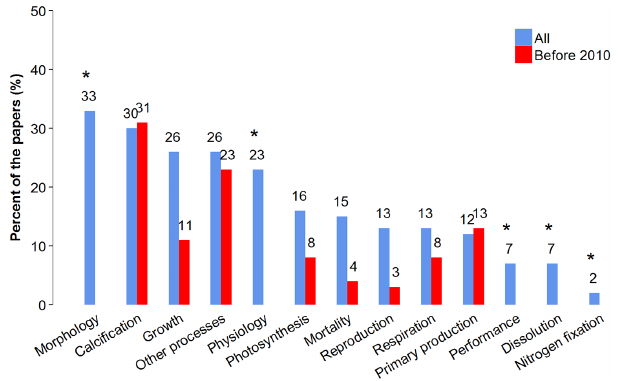
Figure 4. Biological processes reported in the papers from which data have been included in the OA-ICC data compilation, com- pared to those archived prior to 2010. Other processes studied in the papers from which data were archived before 2010 comprise variables such as shell length, width and linear extension of mol- luscs, bleaching, invasion, orientation, different blood cell concen- tration, concentration in the tissues of organisms, rate of nitrogen fixation (Nisumaa et al., 2010). The categories marked with ∗ were not present in Nisumaa et al. (2010) or their definition was differ- ent. “Morphology” was included in “Other processes” in Nisumaa et al. (2010) whereas it is considered as a distinct category in the present paper.